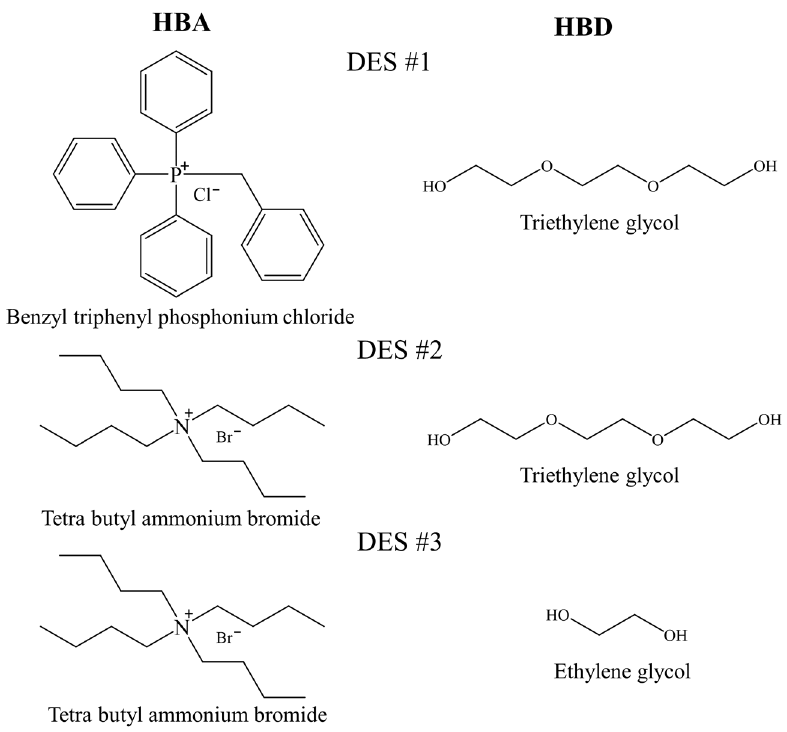
Figure 3. The structures of the DESs used in the experiment process.